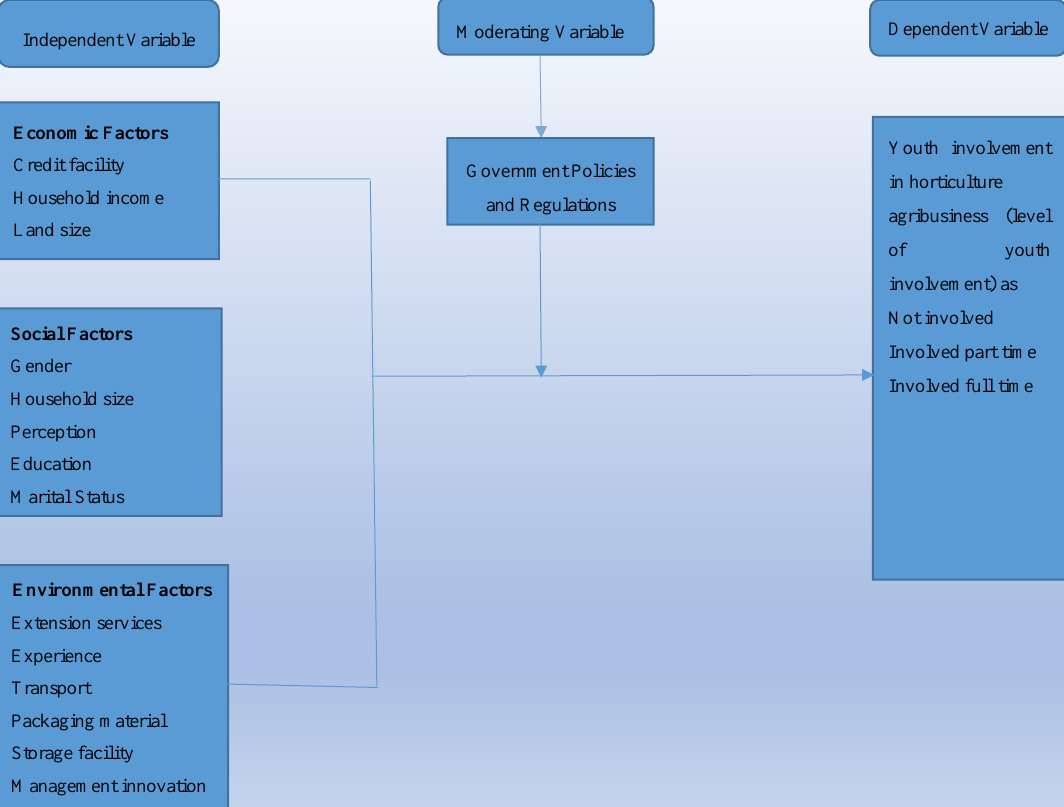
Figure 1. Conceptual Framework. Source: Modified from [18].